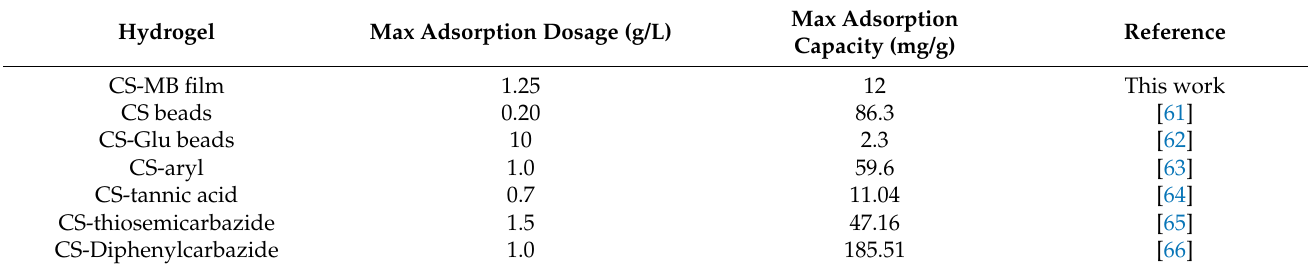
Table 3. Adsorption performance of modified CS hydrogel system.